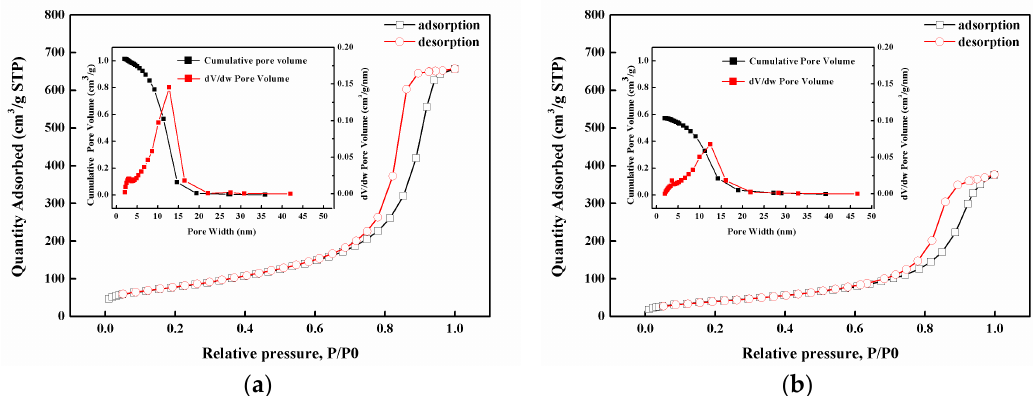
Figure 8. N 2 absorption–desorption isotherms. Insets show the BJH pore size distribution. ( a ) GNP-0 with 0 wt% GNP and 100 wt% MWCNT and ( b ) GNP-50 with 50 wt% GNP and 50 wt% MWCNT.